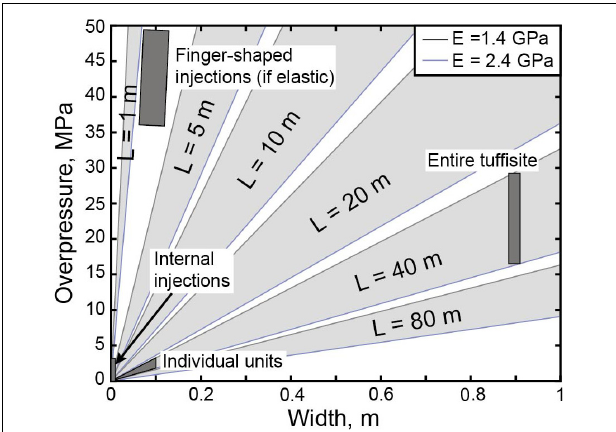
FIGURE 13 | The fluid overpressure required to open tuffisites as a function of fracture width, according to Eq. 2, for different fracture lengths (Gudmundsson, 1983). Plotted pressure fields show the required fluid overpressure to form the tuffisite as a single pulse, or as many individual units, and to form the internal and finger-shaped injections seen. The overpressure estimate for finger-shaped injections plotted is for the elastic model (Eq. 2), but viscous deformation of the surrounding units would decrease the overpressure